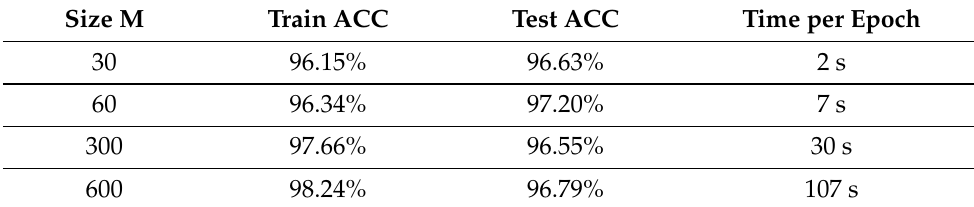
Table 5. Results of different M when N = 60.